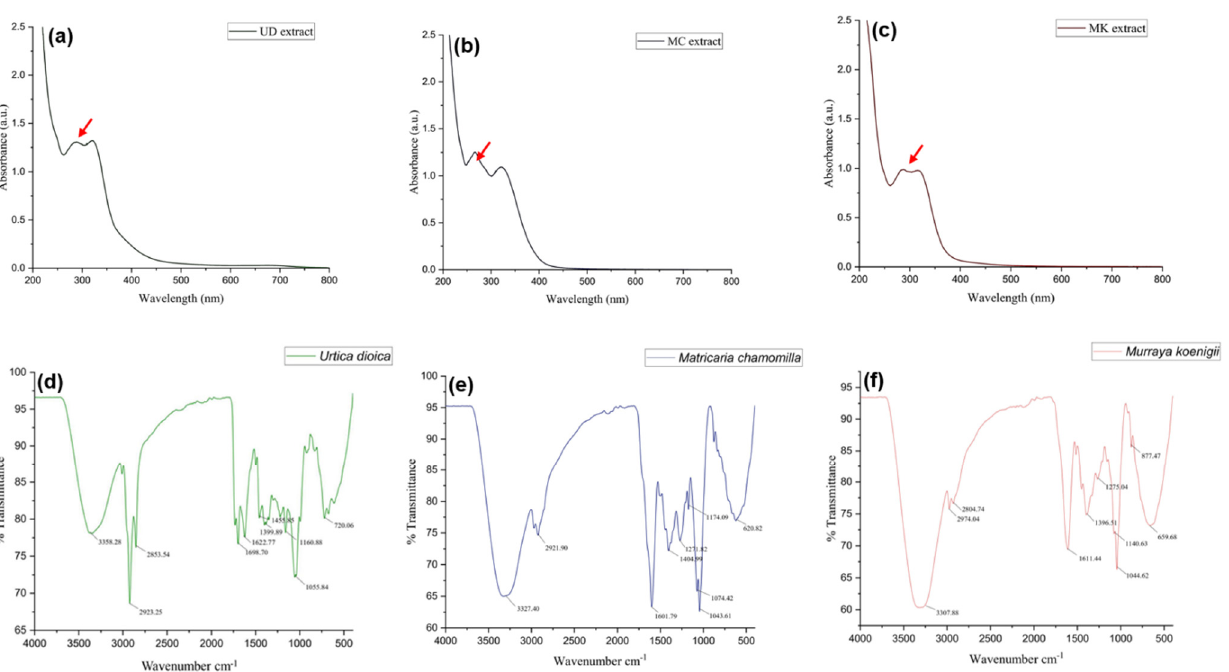
Figure 4. UV-Visible spectra of ( a ) UD, ( b ) MC, and ( c ) MK fractions. Red arrows represent the peak of extract (conjugated or chemical bonds). The FT-IR absorption spectrum of ( d ) UD, ( e ) MC, and ( f ) MK with a scan range of 400–4000 cm − 1 .